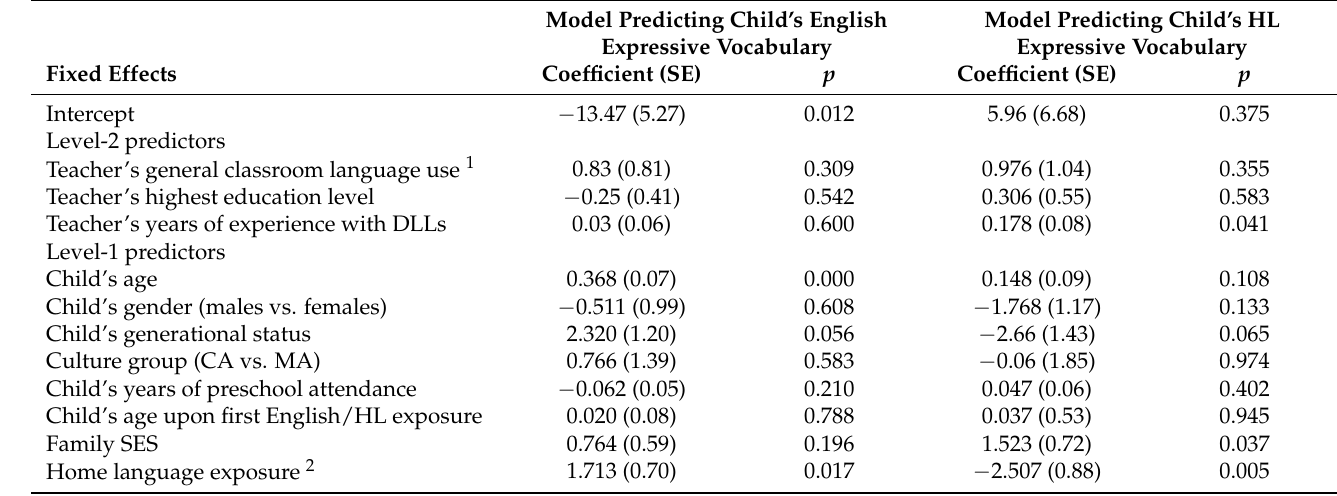
Table 5. Random-intercept models predicting child expressive vocabulary from teacher- and child/family-level